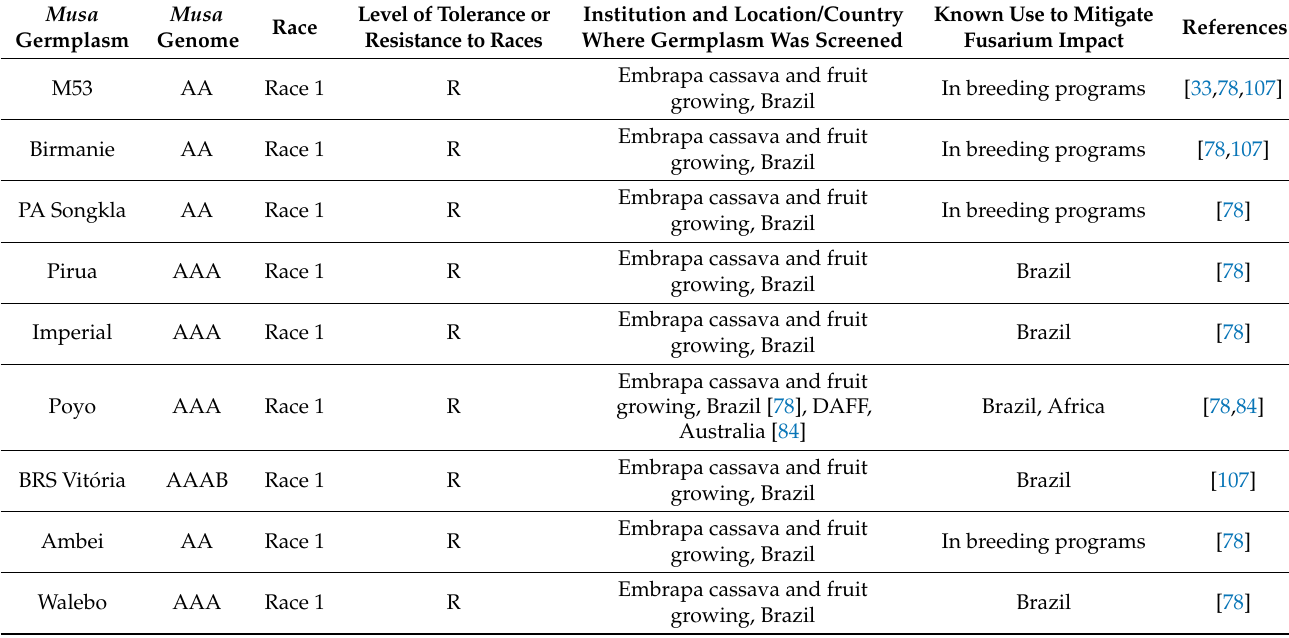
Table 4. Sources of resistance to Fusarium oxysporum f. sp. cubense characterized in articles on the improvement of banana to Fusarium wilt carried out in the last ten